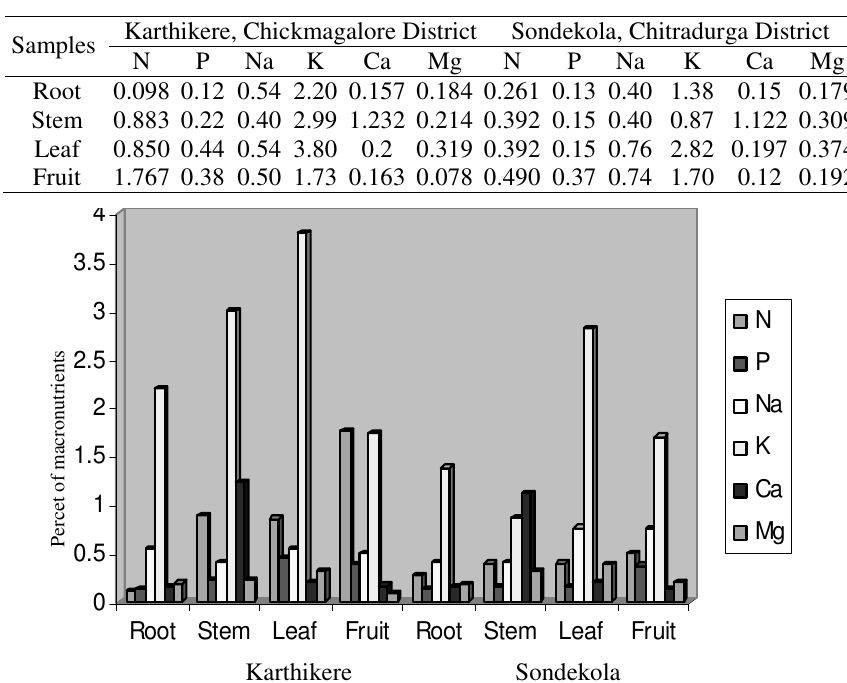
Table 1. Comparative account of macro elements (in percentage) of the root, steam, leaf and fruits samples of Withania somnifera (Linn.) Dunal at Karthikere and Sondekola of Karnataka, India.